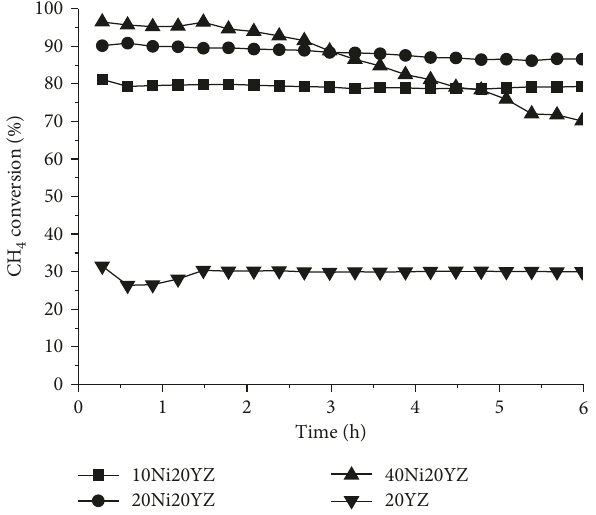
Figure 8: Conversion of CH 4 results obtained during the partial oxidation of methane over the catalysts at 750 ° C (molar ratio of reactants in the inlet stream: 2CH 4 :1O 2 ; molar total flow 107mL · min − 1